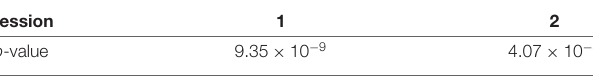
TABLE 4 | The Kruskal-Wallis test results of three trials in two sessions. Session 1